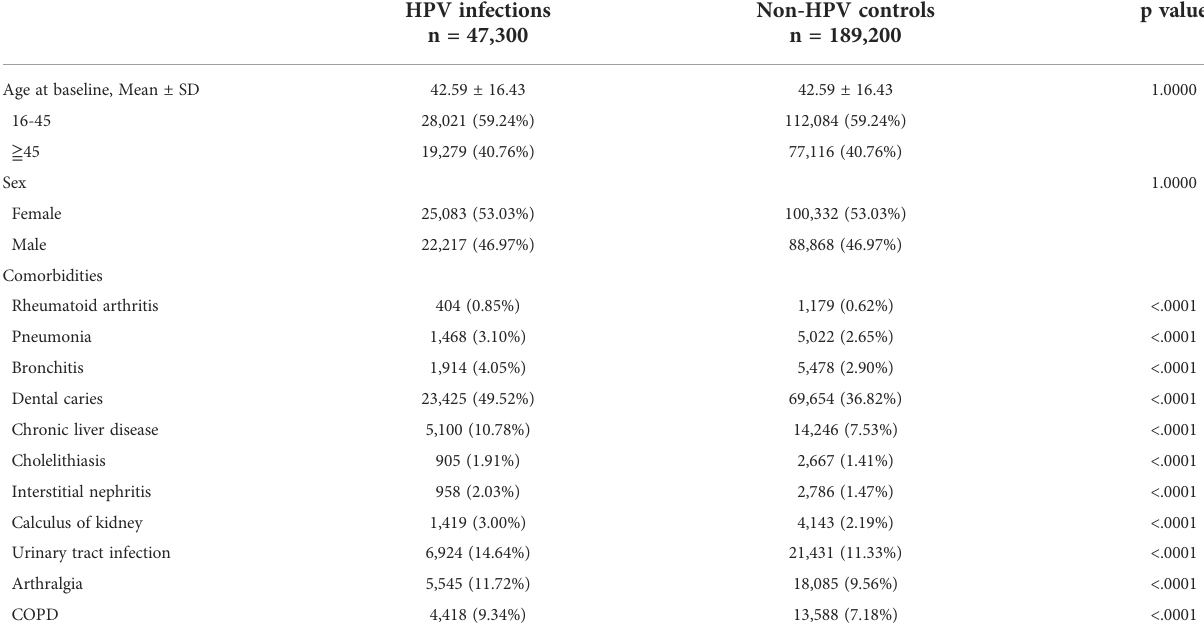
TABLE 1 Characteristics in study groups at